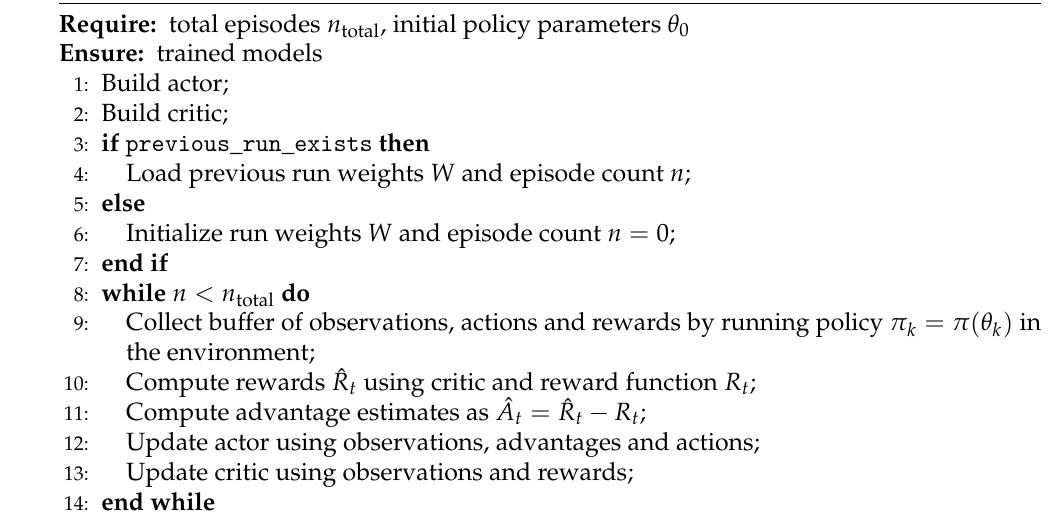
Algorithm 1 Training policy of the actor and critic